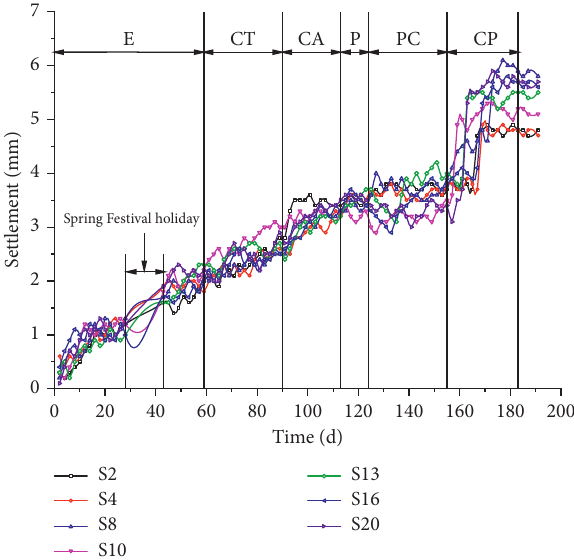
Figure 20: Observed profile of in situ